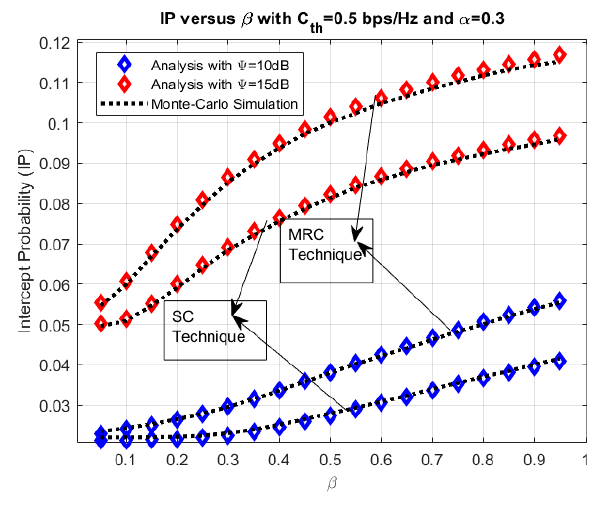
Figure 4. IP versus β .